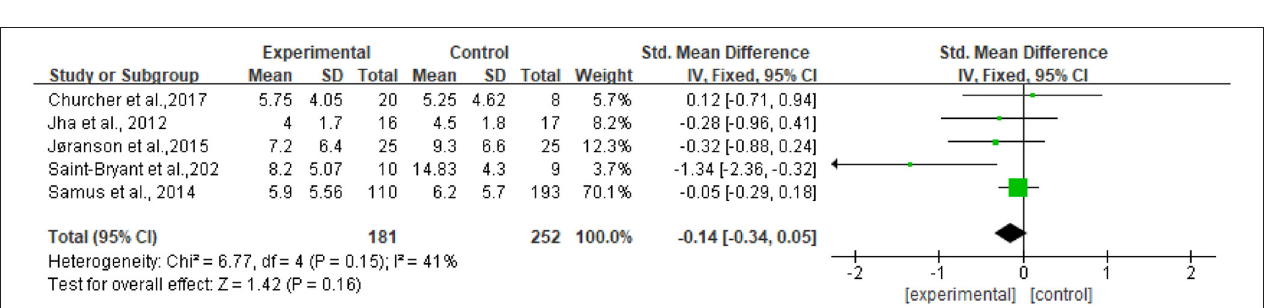
FIGURE 5 | Sensitivity analyses of the intervention group vs. the control group on QOL-AD rating scores.